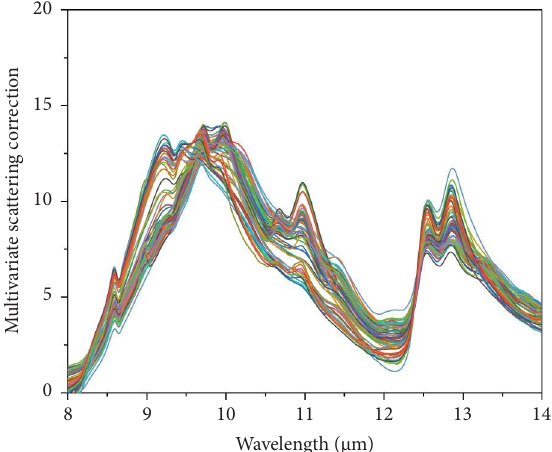
Figure 5: Absorption spectra by